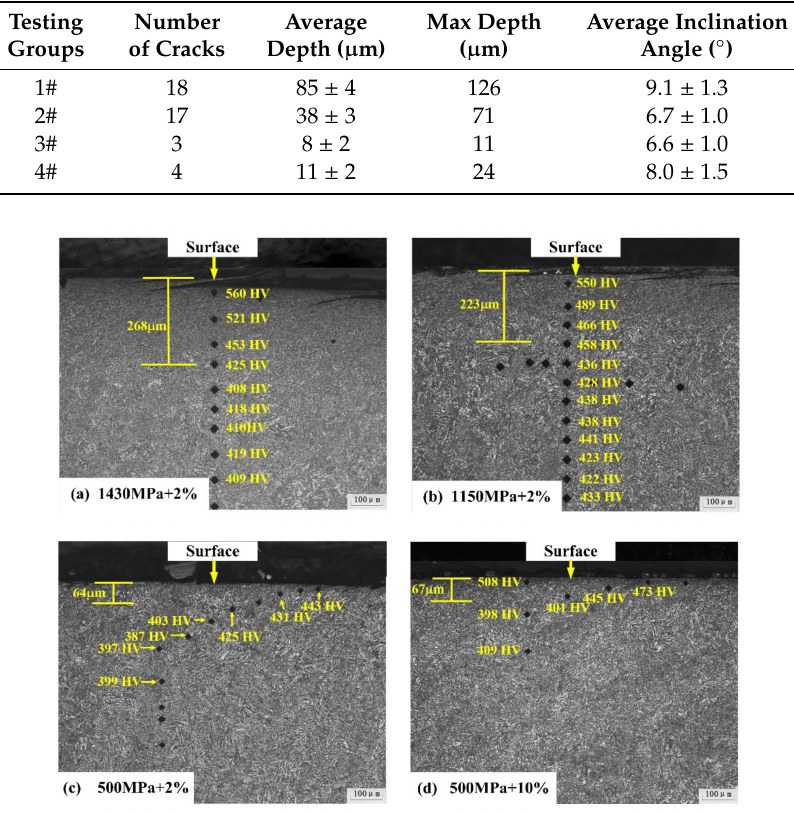
Figure 9. Microhardness of subsurface layer in the tested bainitic rail steels (HV 50 g) ( a ) 1430 MPa + 2%, ( b ) 1150 MPa + 2%, ( c ) 500 MPa + 2% and ( d ) 500 MPa +